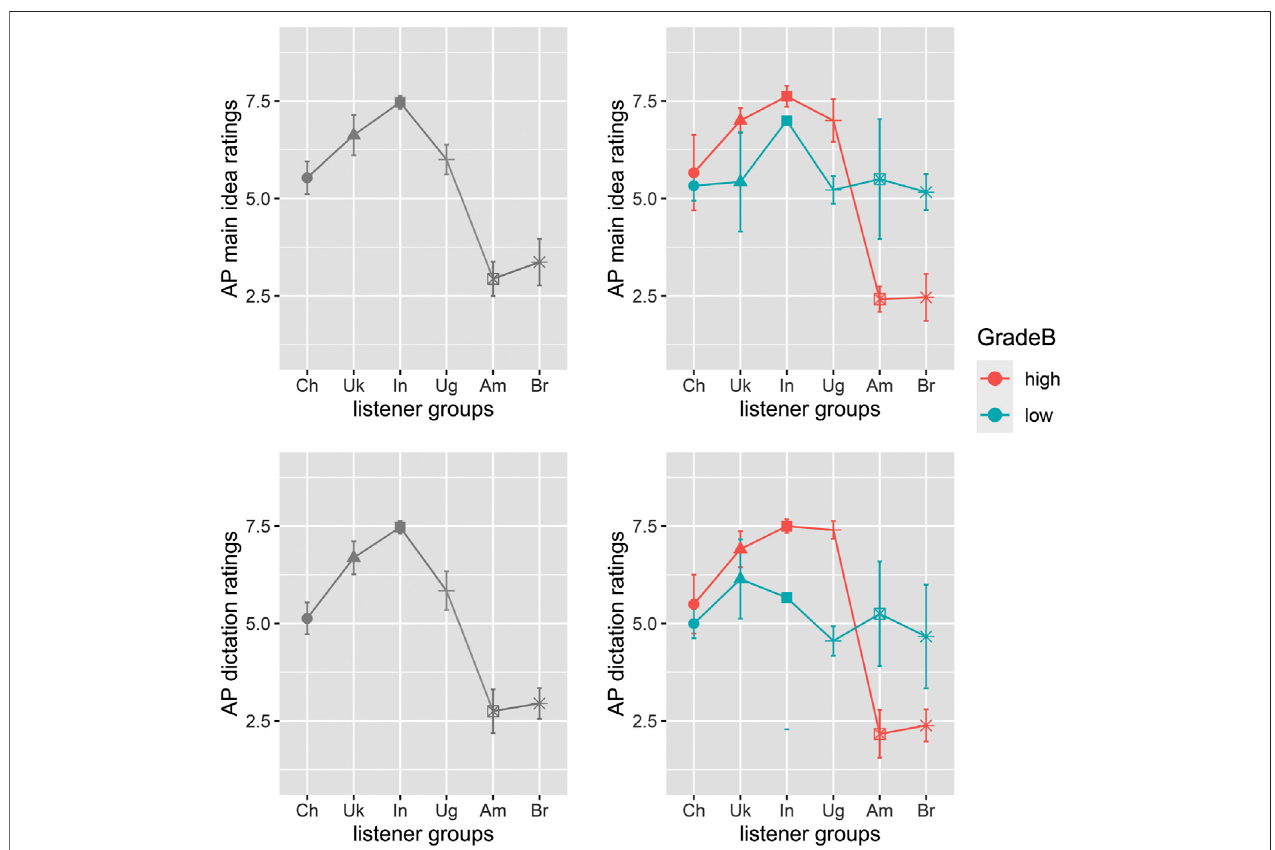
FIGURE 3 | Accentedness perception groups (left) and groups*English grades (right) plots using 20% trimmed means and standard errors: Note. Subject numbersare:Ch (cid:1) 23(high (cid:1) 10andlow (cid:1) 13),Uk (cid:1) 26(high (cid:1) 17andlow (cid:1) 9),In (cid:1) 27(high (cid:1) 24andlow (cid:1) 3),Ug (cid:1) 29(high (cid:1) 14andlow (cid:1) 15),Am (cid:1) 26(high (cid:1) 20and low (cid:1) 6), Br (cid:1) 29 (high (cid:1) 19 and low (cid:1)